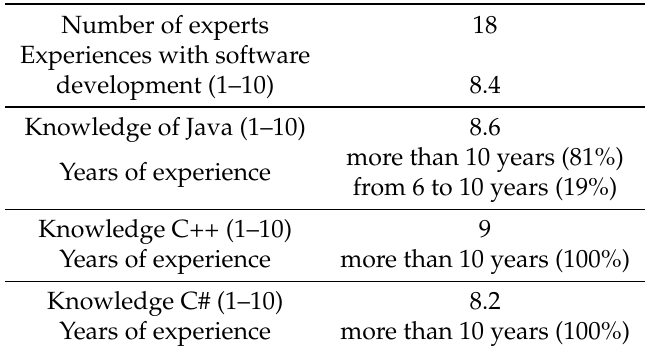
Table 9. Profiles of participating